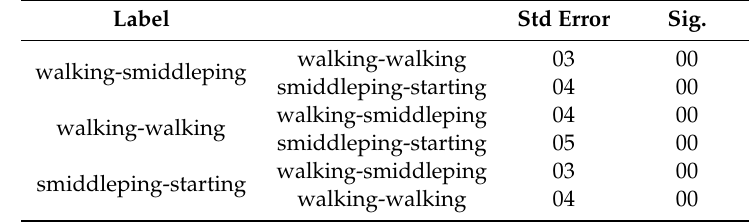
Table 6. Post-hoc comparison table.